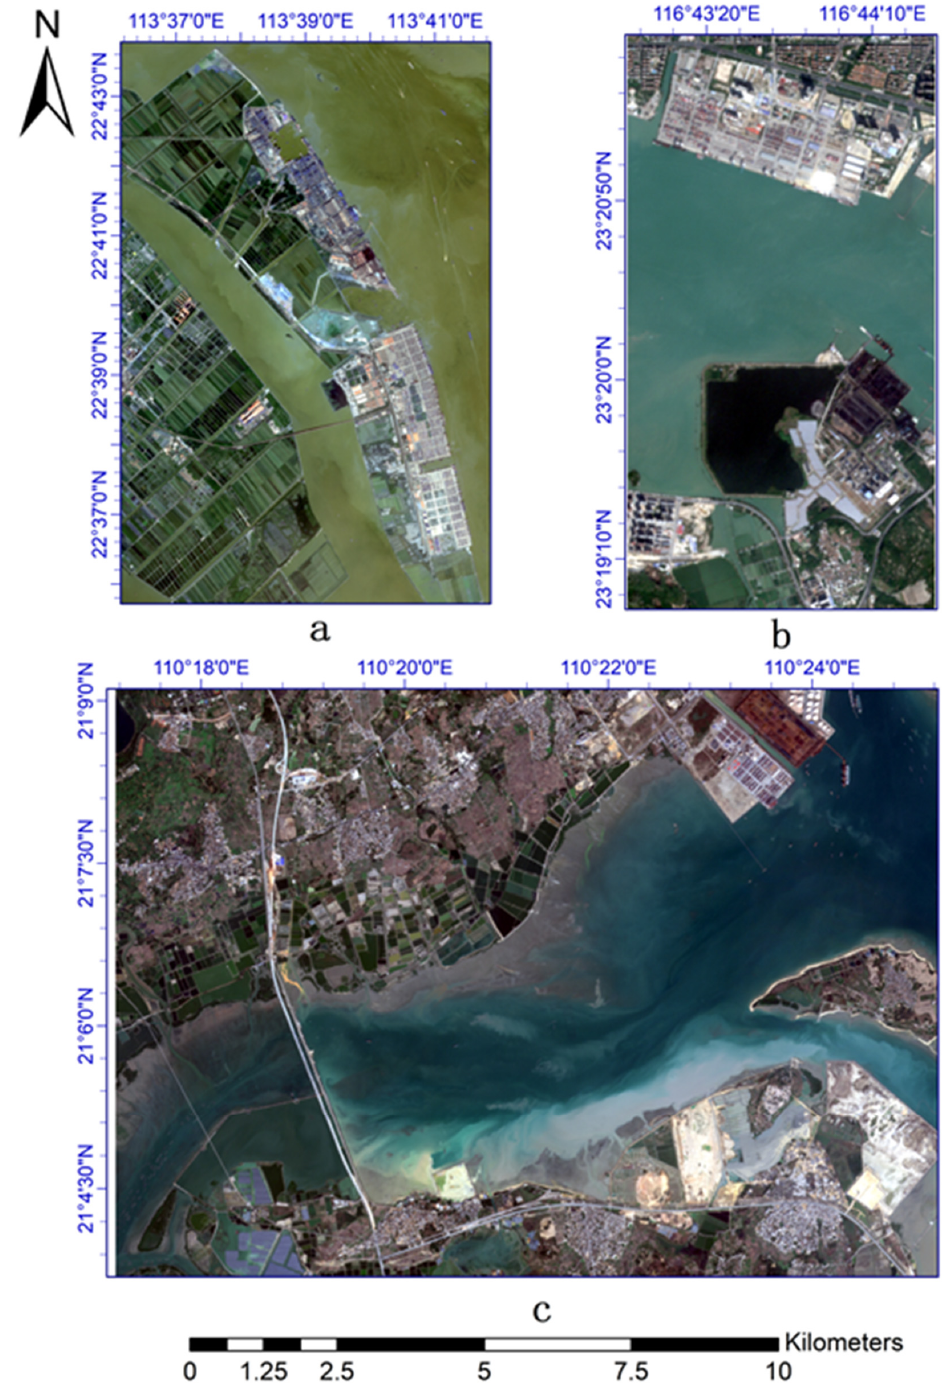
Figure 3. Sentinel 2A MSI false-color composites over ( a ) Pearl River Delta, ( b ) east Guangdong, and ( c ) west Guangdong.